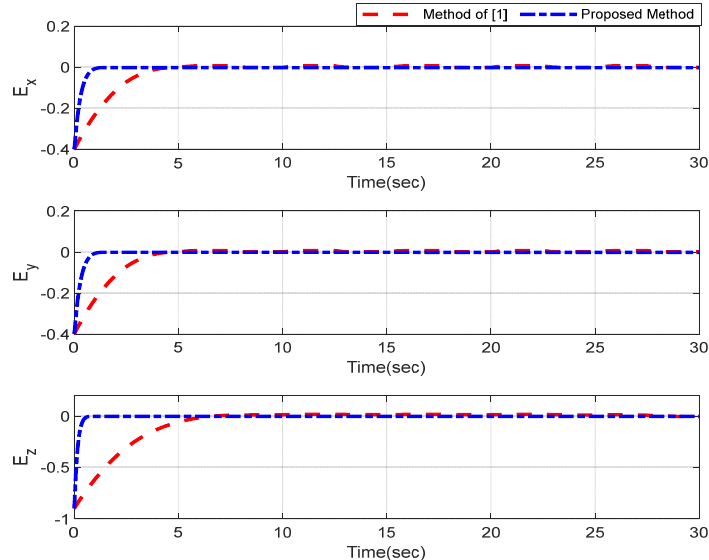
Figure 4. Trajectories of position tracking errors.